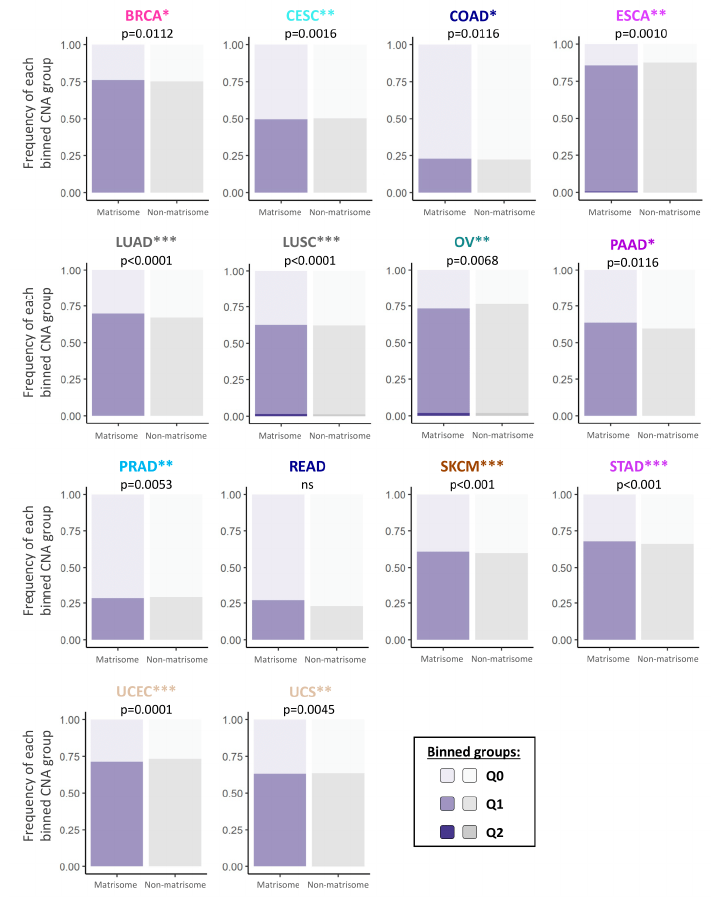
Figure 1. Frequency of copy number alterations of matrisome genes across 14 different cancer types. Bar charts represent the frequency of CNAs in matrisome genes (purple bars) and non-matrisome genes (rest of the genome, grey bars) across 14 different cancer types. Chi-square test p -values, (calculated on the frequency per binned categories) are indicated for each cancer type (* p < 0.05; ** p < 0.01; *** p < 0.001). Binned groups are represented by different shades of purple and grey to represent genes in which CNAs are found in x% of the samples: Q0 = 0% (lighter shade), 0% < Q1 ≤ 25%, 25% < Q2 ≤ 50% (darker shade). See also Figures S1 and S2, and Table S1.